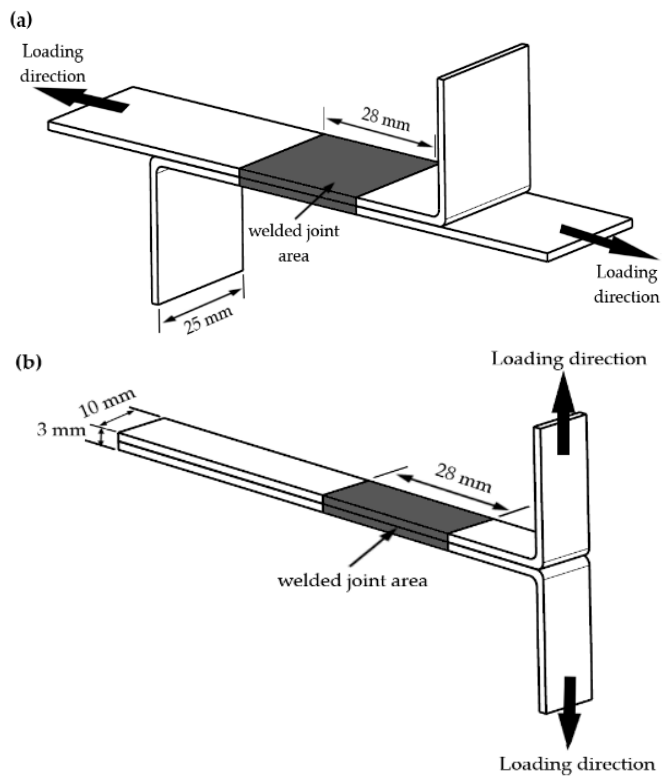
Figure 4. The dimension of the samples; ( a ) shear test and ( b ) peel test.